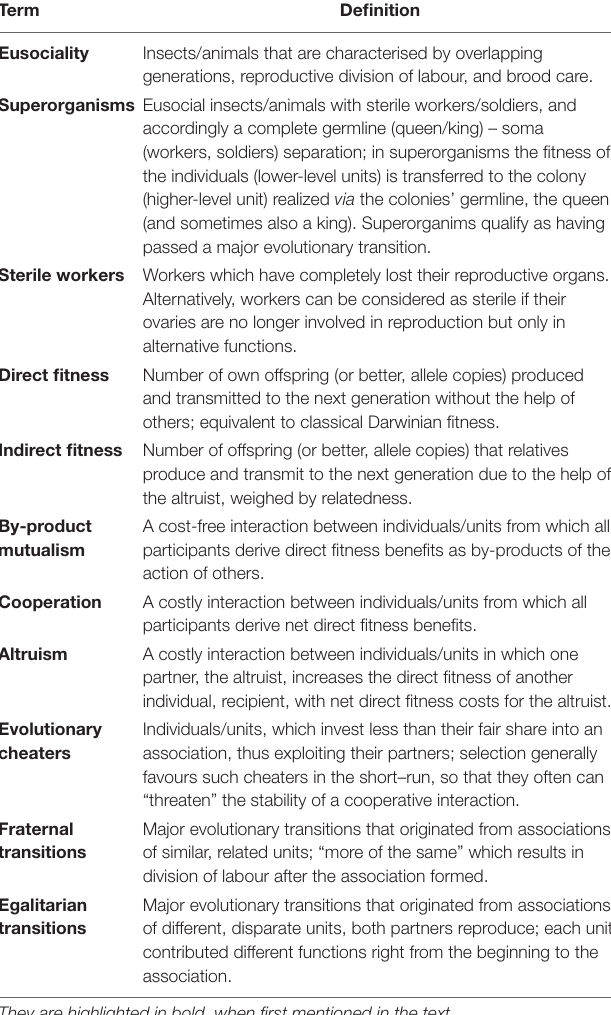
TABLE 1 | Definition of terms used in the paper.